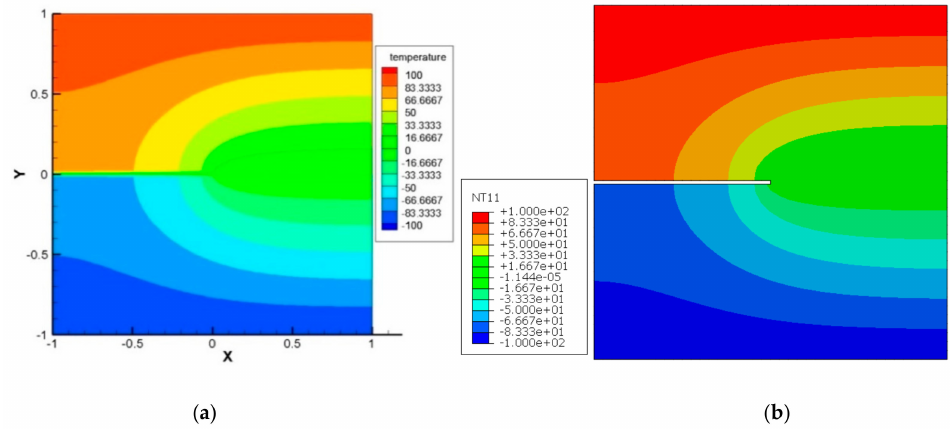
Figure 15. Temperature contour in case of edge crack at t = 100 s. ( a ) PD result, ( b ) FEM